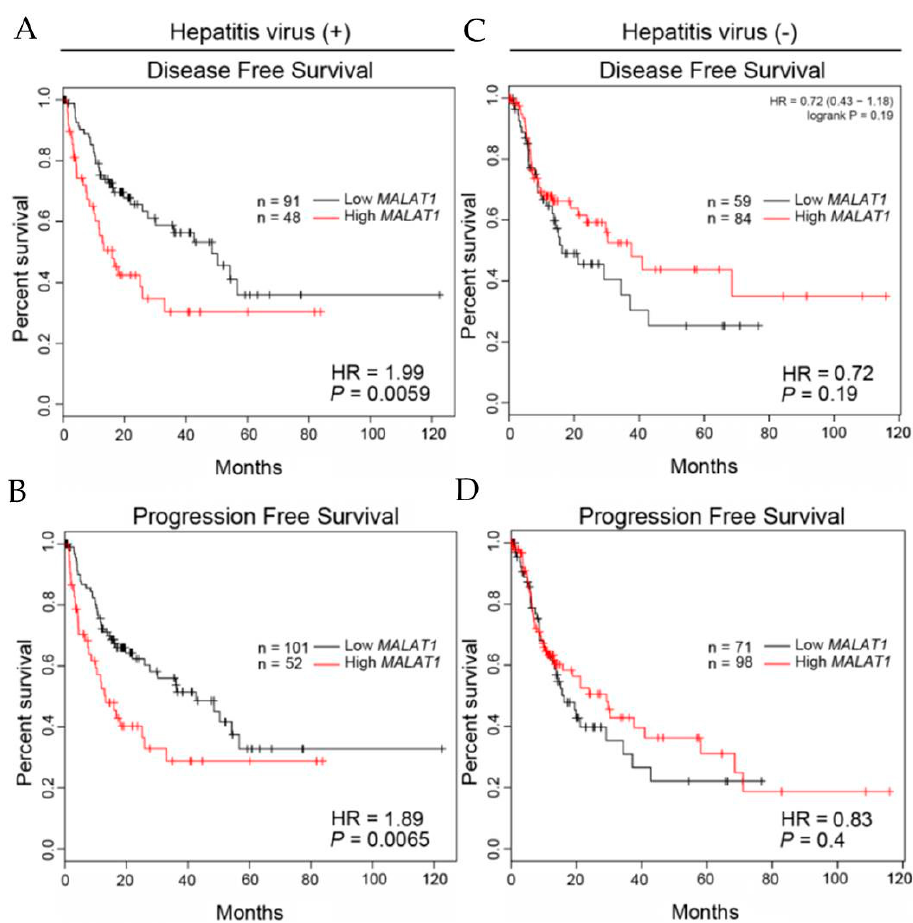
Figure 2. Prognostic significance of MALAT1 in hepatocellular carcinoma (HCC) patients with ( A , B ) or without ( C , D ) hepatitis virus infection. Kaplan–Meier plots of disease-free survival (DFS) and progression-free survival (PFS) of HCC patients with or without hepatitis virus infection which were analyzed by the KM plotter. Overall DFS and PFS predicted by low versus high MALAT1 expression. HR, hazard ratio.